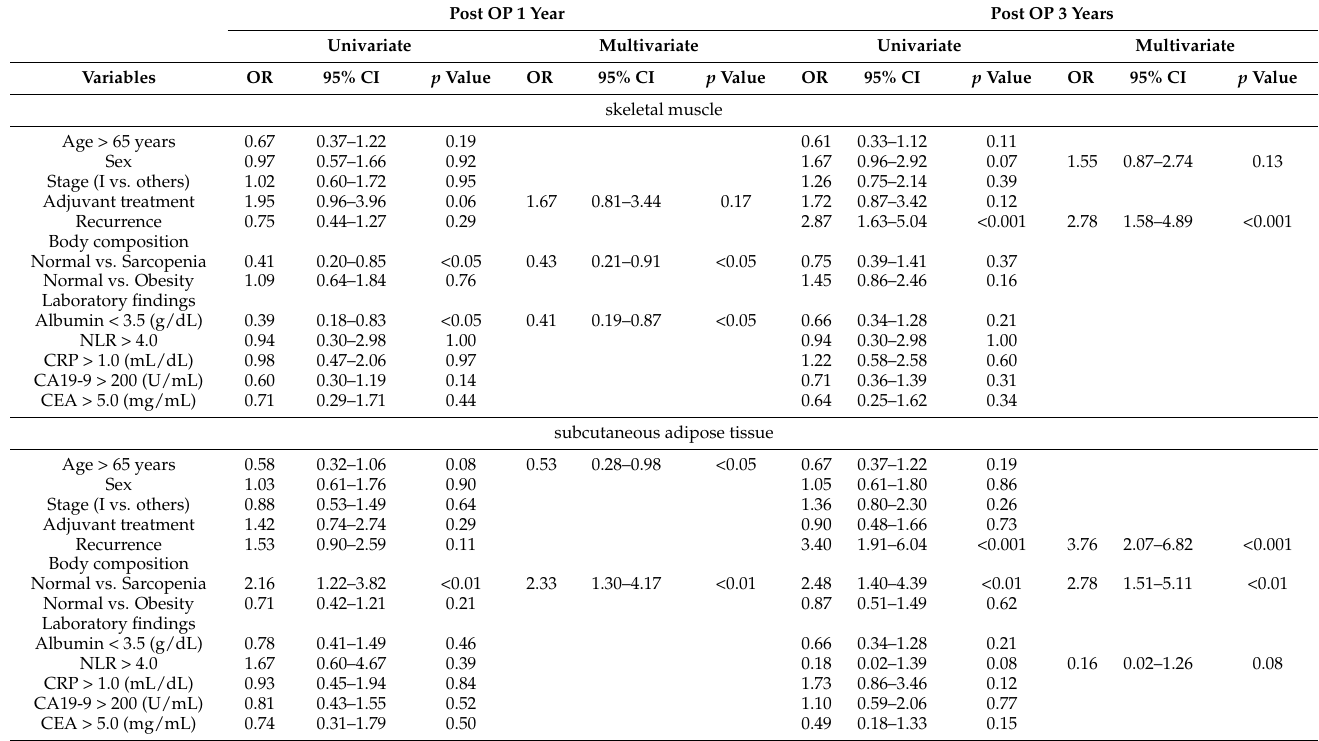
Table 3. Univariate and multivariate analysis of factors affecting changes in body